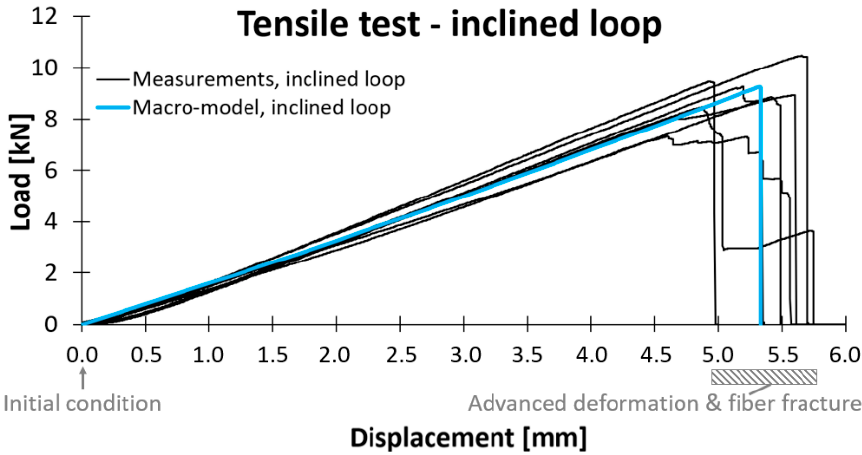
Figure 23. Load-displacement curves from tensile tests on inclined loops (measured and calculated).